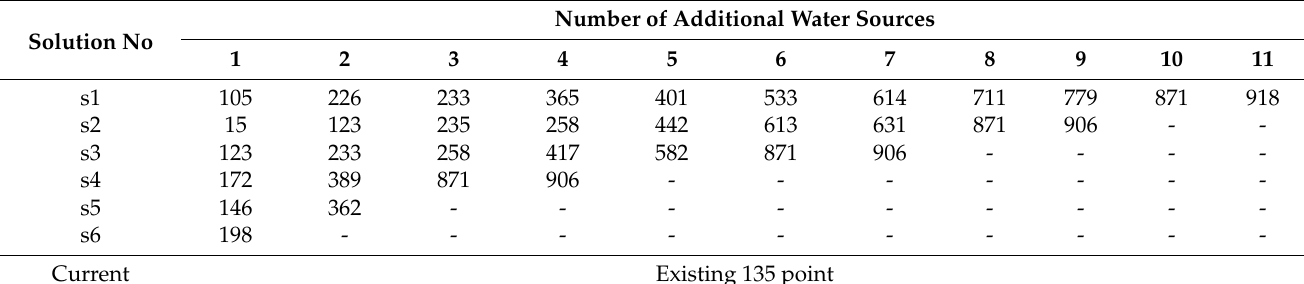
Figure 21. Visualization of s1. Table 4. Grid numbers of additional optimal water source locations.